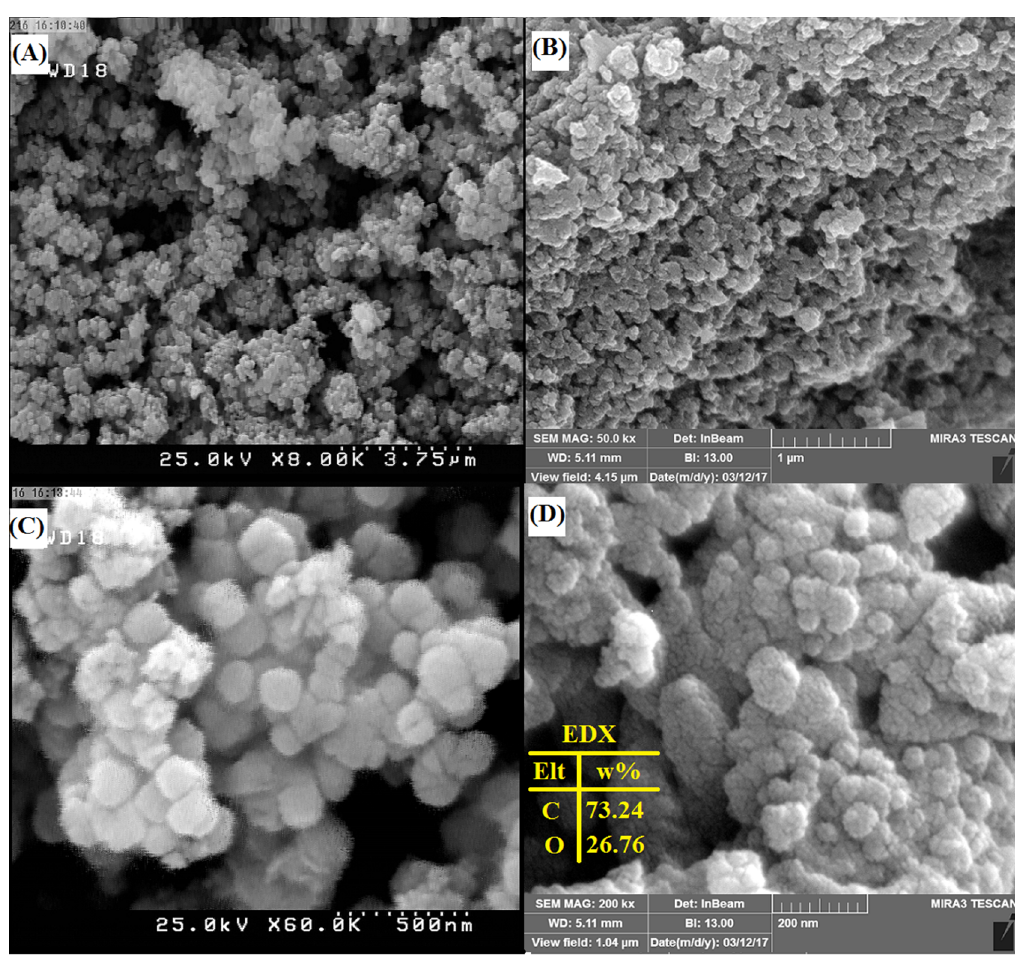
Figure 4. The FE-SEM micrographs of PG-AC5 with different scales ( A ) 3.75 µm, ( B ) 1 µm, ( C ) 500 nm and ( D ) 200 nm.